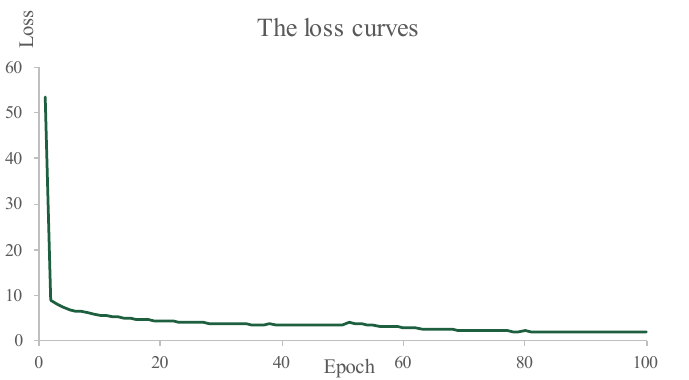
Figure 10. Training loss curve.